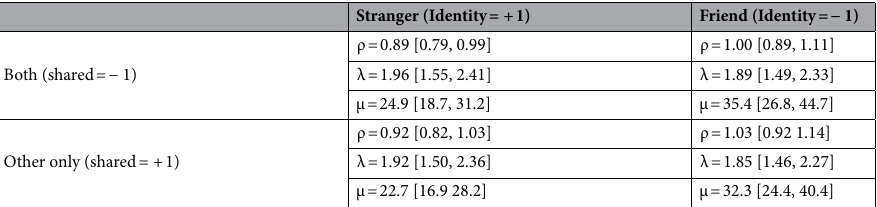
values from their respective “self” means of 1.07, 1.78, and 18.0 (see above) to “other” means of 0.96, 1.90, and 28.3 (ignoring effects of sharing or identity, detailed in the following paragraphs and summarized in Table 1). Estimates of the additive effects of ‘sharing’ on value parameters representing decision processes in the nonlinear model revealed no reliable effect on loss aversion (95% HDI [− 0.03, 0.01]) or choice consistency (95% HDI [− 0.10, 0.01]), and only a weak change in risk attitudes (M = 0.016, SD = 0.008; while the 95% HDI included zero, [− 0.001, 0.03], 96.9% of samples were above zero; note that the coding of the variable by which this parameter was multiplied (see Methods) was + 1 Other-only, − 1 Shared, 0 Self only). This marginal effect would imply average ρ values of 0.96 for choices involving only the other versus 0.94 for choices with outcomes shared between the participant and the other (ignoring effects of identity, see below), suggesting slightly more risk aversion for choices with shared outcomes. The directionality of this effect suggests a specific influence of the context of sharing on risky choice via risk attitudes only such that sharing outcomes with others makes people only marginally more conservative (i.e., risk averse) than when solely choosing for others. Lastly, reliable effects of ‘identity’ (coded as + 1 stranger, − 1 friend, 0 self, see Methods) on both risk attitudes and choice consistency also emerged in Model 1. Choices involving strangers relative to friends reflected more risk aversion (M = − 0.05, SD = 0.02, 95% HDI [− 0.09, − 0.02]) and less consistency (M = − 0.18, SD = 0.05, 95% HDI [− 0.28, − 0.07]), but no changes in loss aversion (M = 0.02, SD = 0.02, 95% HDI [− 0.03, 0.06]). These effects would imply average ρ values of 1.03 for friends, and 0.92 for strangers, making people risk averse when choosing for strangers, but risk neutral when choosing for friends (assuming choices were made only for the other and not shared; see above). The implied average values of µ (representing choice consistency) were 32.3 for choices involving friends versus 22.7 for choices involving strangers, indicating noisier choices for strangers/more stable choices for friends. Interestingly, loss aversion did not appear to reliably differ as a function of partner identity. For an alternative visualization of the behavioral effects captured by the model, see Fig. S1, which plots the predicted probability of making a risky choice given (1) the difference in expected value between the risky and safe options and (2) the condition in the study, calculated using the group-level average estimates from Model 1. Model 2: individual differences and the relationships between decision computations and social cognitive meas‑ ures. In Model 2, we estimated our ‘other’ term with hierarchical group-level fixed and subject-level random effects in order to obtain individual estimates of the degree to which participants showed changes in decision processes in social contexts. Doing so allowed us to examine the extent to which any individual differences in risky decision-making for another were related to measures of social cognition and risk perception. See Supple- mentary Materials S1 for additional context for Model 2’s design. Model 2 replicated Model1’s findings at the group level. Group-level fixed effects estimates of the effect of the ‘Other’ term on risk attitudes (M = − 0.14, SD = 0.05, 95% HDI [− 0.23, − 0.05]) and loss aversion (M = 0.14, SD = 0.07, 95% HDI [0.02, 0.28]), were consistent with Model 1, finding that choosing when another person is involved increases risk aversion and loss aversion (there were no reliable effects on choice consistency, though the direction of the effect was the same: 95% HDI [− 0.09, 0.37], with 87.8% of samples above zero). Model 2 additionally replicated the pattern of results for ‘Sharing’ found in Model 1: no reliable additive effects of shar- of samples above zero). Note that post-hoc comparisons of the other effect in Model 2 replicated the pattern of results in Model 1 for strangers versus friends, see Supplementary Material S1. Critically, obtaining individual estimates of people’s sensitivity to social context during value processing and risk evaluation allowed us to explore relationships between the mechanisms of decision-making and individual difference measures assessing general risk attitudes and empathy. Pearson’s correlations (see Fig. 4a,c) revealed significant relationships between the DOSPERT social subscale and risk-related decision processes: participants who reported being more socially risky unexpectedly became more loss averse ( r (51) = 0.302, p = 0.028) and more